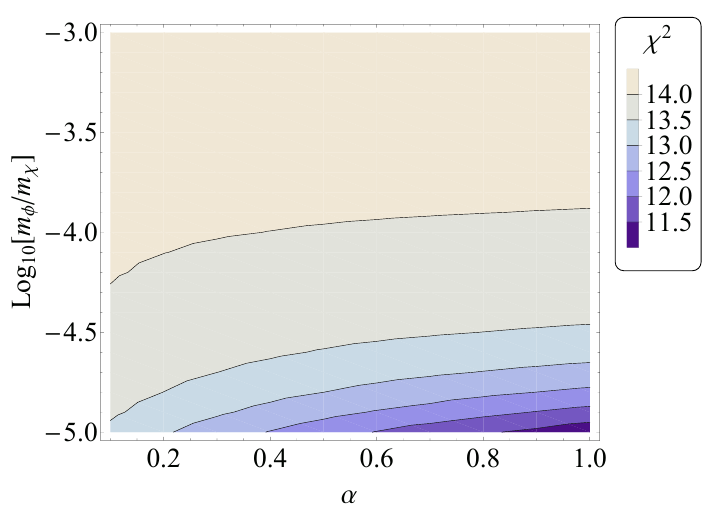
Figure 4 . Chi-squared distribution over α − m φ /m χ plane. The DM mass is set to be 10 3 GeV